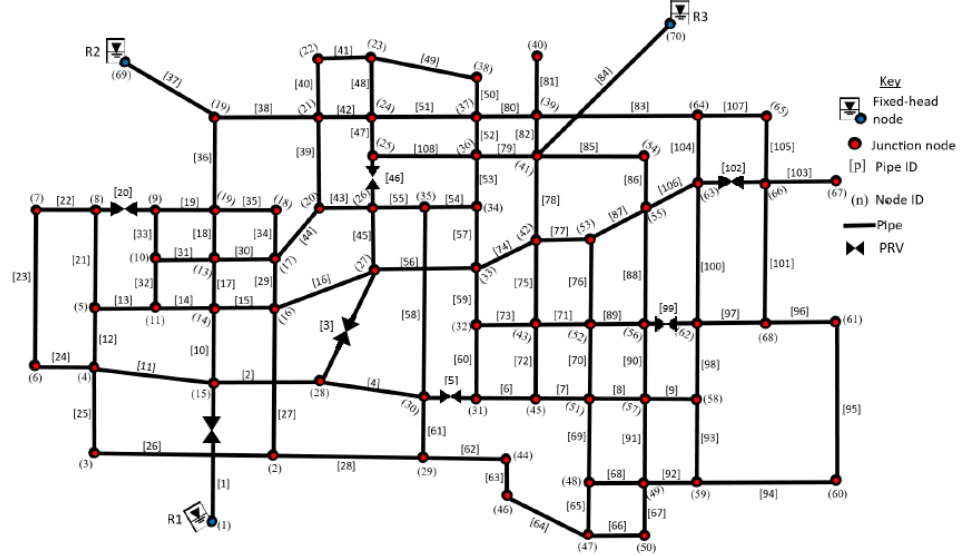
Figure 3. Case Study Water Distribution Network.